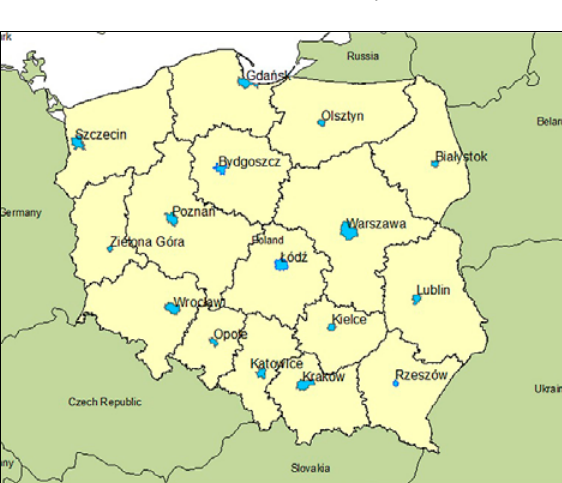
Fig. 3. Main real estate markets in Poland Source : own